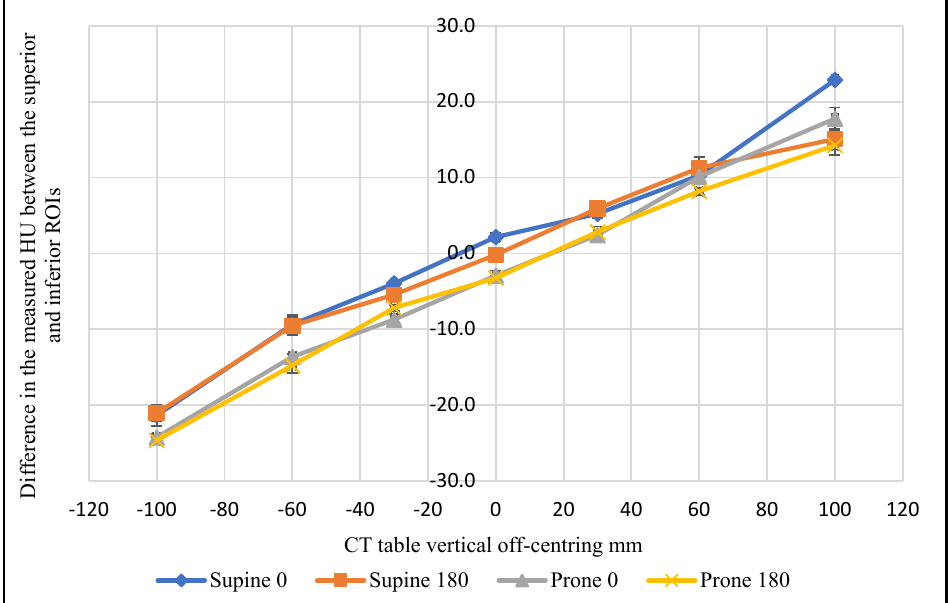
Figure 4. The difference in the mean CT number in the abdominal section between the superior and inferior ROIs as a function of vertical off-centring, phantom position, and localiser direction, at 120 kVp.